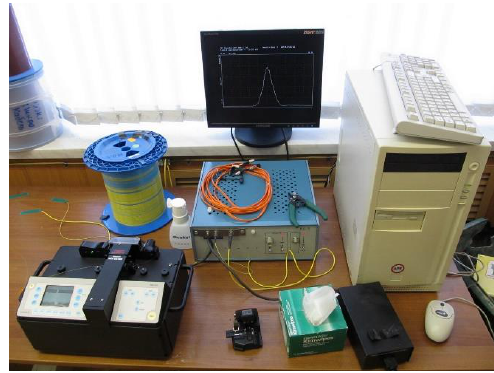
Figure 10. Experimental setup.